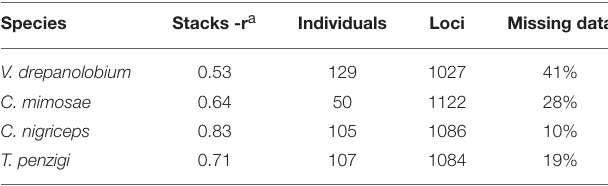
TABLE 3 | Results of RADseq sequencing and